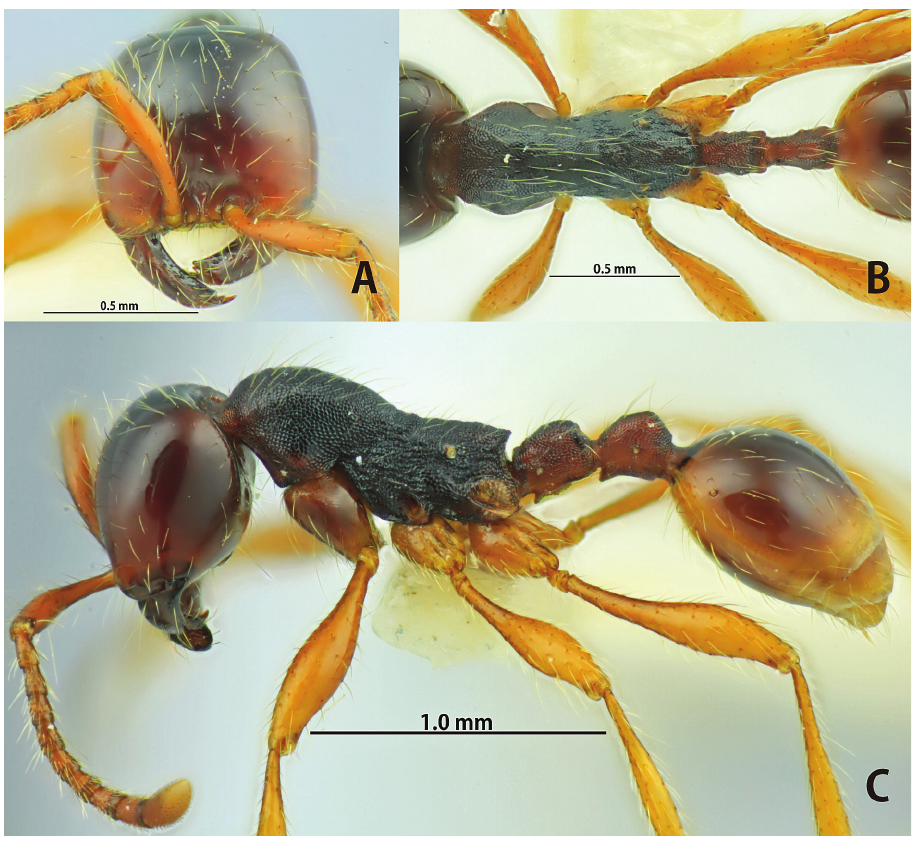
Figure 16. Aenictus pinkaewi (holotype). A Head in full-face view B body in dorsal view C body in concave, encircled with a rim. Petiole cylindrical, distinctly longer than high, with its dorsal outline slightly elevated posteriorly; posterior face of petiole shallowly concave, and encircled with a thin carina; subpetiolar process generally very low, with its anter- oventral corner acutely angulate, and ventral outline feebly convex. Postpetiole almost as long as petiole, node convex dorsally and elevated posteriorly.